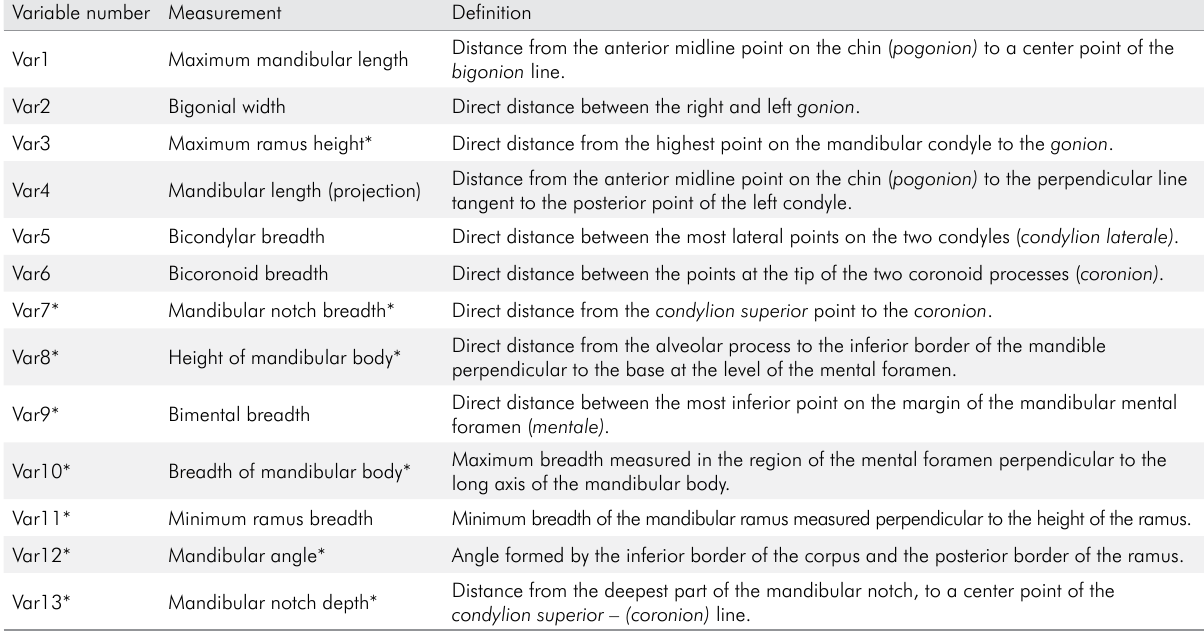
*Bilateral measurements (left and